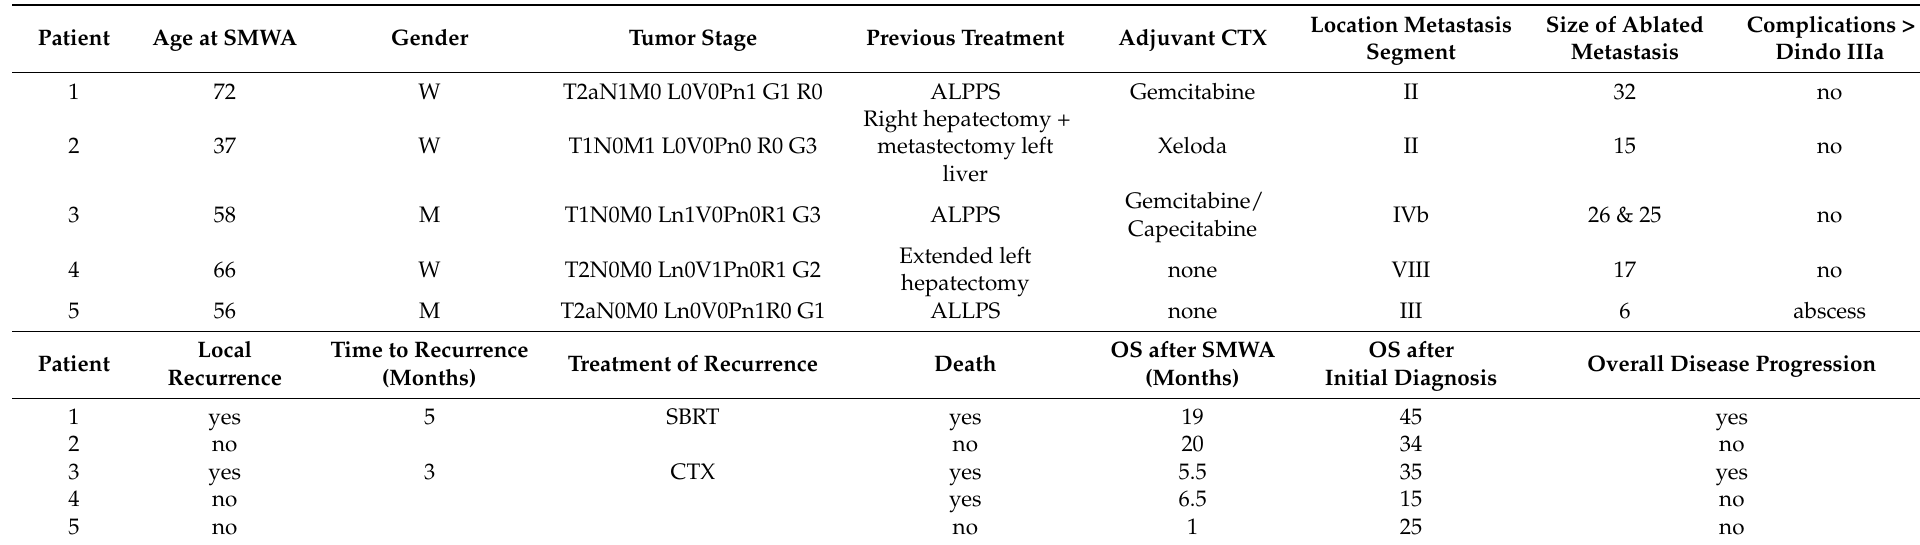
Table 3. Patients with ICC metastases treated by